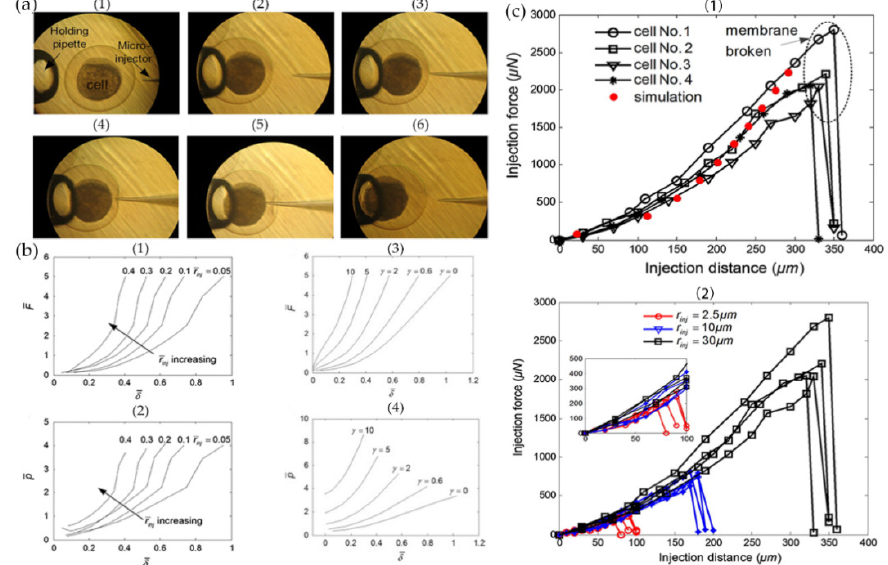
Figure 7. Injection model. ( a ) (1)–(6) Zebrafish cell injection experiment. ( b ) (1),(2) The injection force F and cell internal pressure P vary with the injection distance δ under di ff erent injection radii; (3),(4) the injection force F and internal pressure P vary with the injection distance δ under di ff erent materials. ( c ) (1) Experimental data of injection force and injection distance under 30 µ m injection radius when membrane of di ff erent cells break; (2) experimental data of injection force and injection distance under di ff erent injection radii when membrane of cells break. (Adapted by kind permission from [170]).